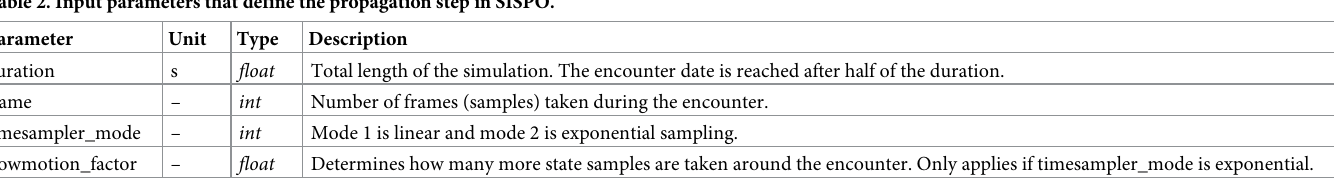
Table 2. Input parameters that define the propagation step in